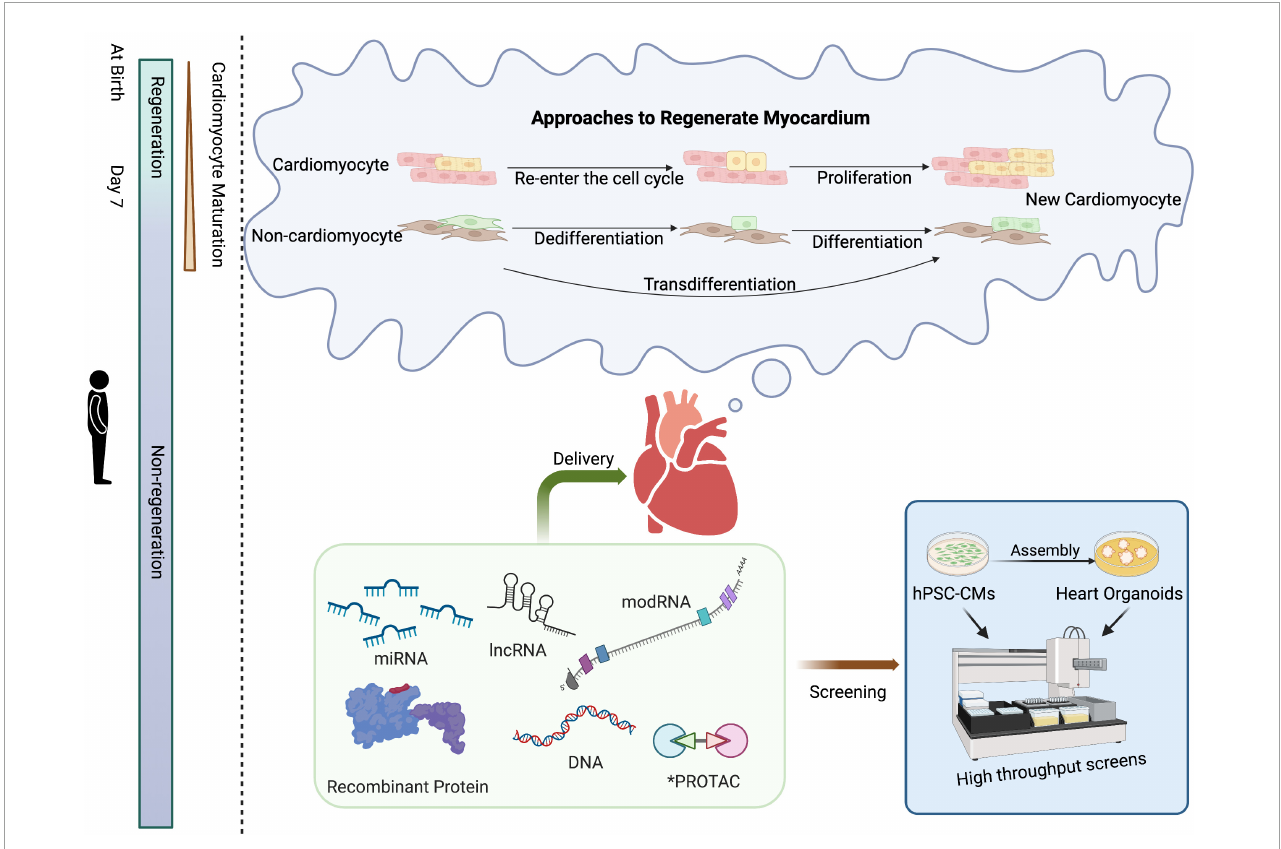
FIGURE1 Schematic of approaches for cardiac regenerative medicine using cell-free therapies. Mammals have the intrinsic capability to structurally and functionally regenerate their hearts shortly after birth, a capacity that is subsequently lost. Approaches to cardiac regeneration involve the re-entry of cardiomyocytes into the cell cycle and/or transdifferentiation of other resident cell types into cardiomyocytes. Recombinant proteins, RNA-based drugs, PROTAC, or small molecules could serve as viable strategies for cardiac repair. High-throughput screening of drug candidates can be performed in hPSC-CMs or, at lower throughput, cardiac organoids prior to clinical application. Created with